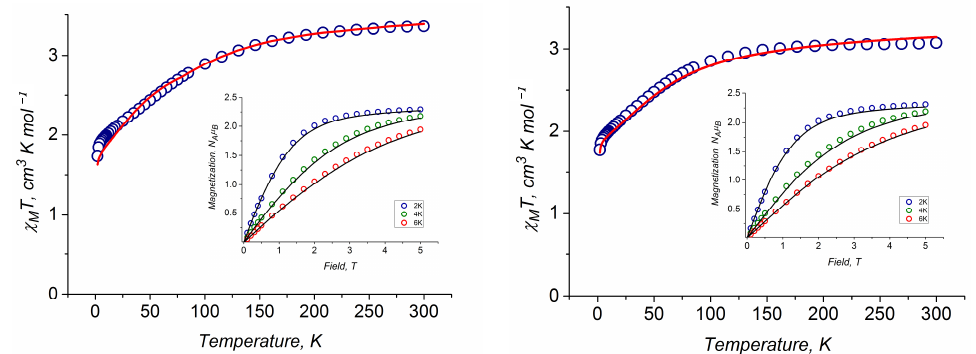
Figure 3. Temperature dependences of χ M T for 1 ( left ) and 2 ( right ) measured at H DC = 0.5 T. Insets: magnetization vs. field measured at T = 2, 4, and 6 K. Theoretical curves (solid lines) are calculated at GH (Equation (1)) with the optimal set of parameters (see text).